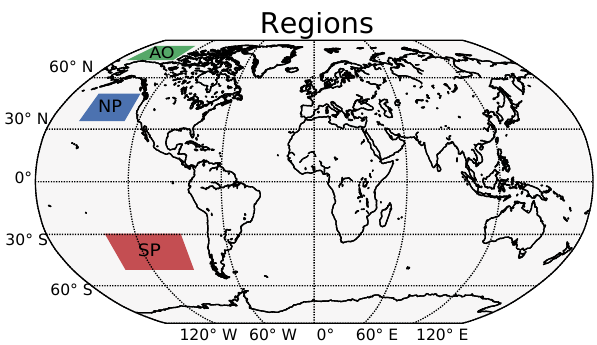
Figure 8. Selected regions with extra focus. AO is the Arctic Ocean (70–82 ◦ N, 130–170 ◦ W). NP is the North Pacific (35–50 ◦ N, 130– 160 ◦ W). SP is the South Pacific (30–50 ◦ S, 90–140 ◦